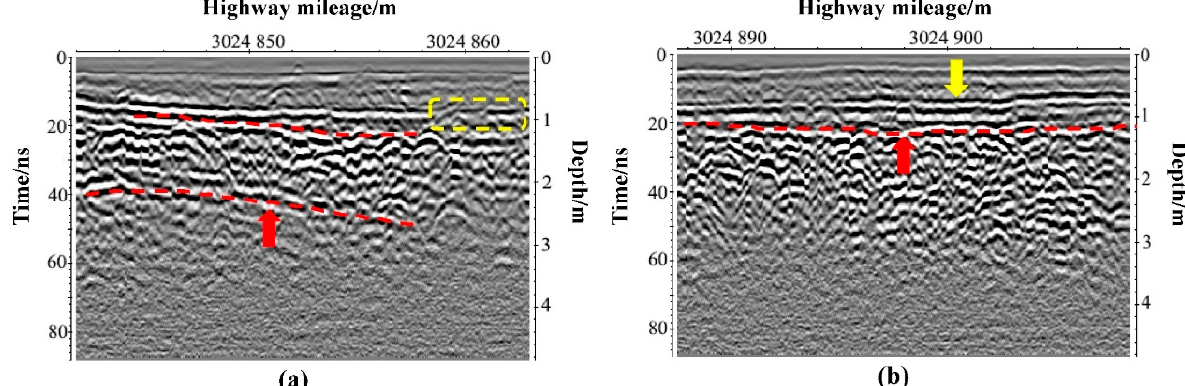
Figure 10. GPR images indicating the settlement of the block-stone layer: ( a ) K3024 + 842 to K3024 + 863; ( b ) K3024 + 887 to K3024 + 909. The yellow dashed box shows the abnormal area of the sand-gravel layer, the red dotted line indicates the settlement trend of the block-stone layer, and the yellow and red arrow is used to facilitate reading.